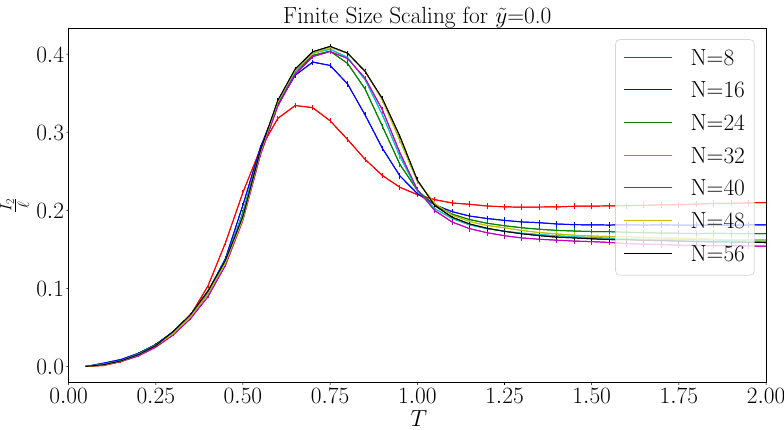
Figure 8 . Finite size scaling for RMI of (4.26) with ~ y = 0. The curves cross at T which are the values of T c = 2 and T c , respectively.